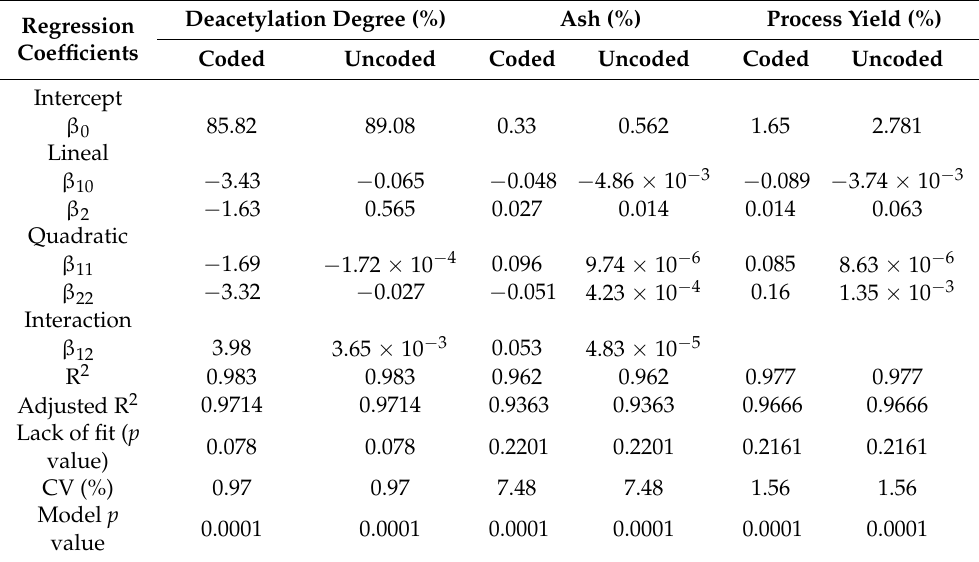
Table 2. Regression coefficients and variance analysis of polynomial models for lactic fermentation extraction of